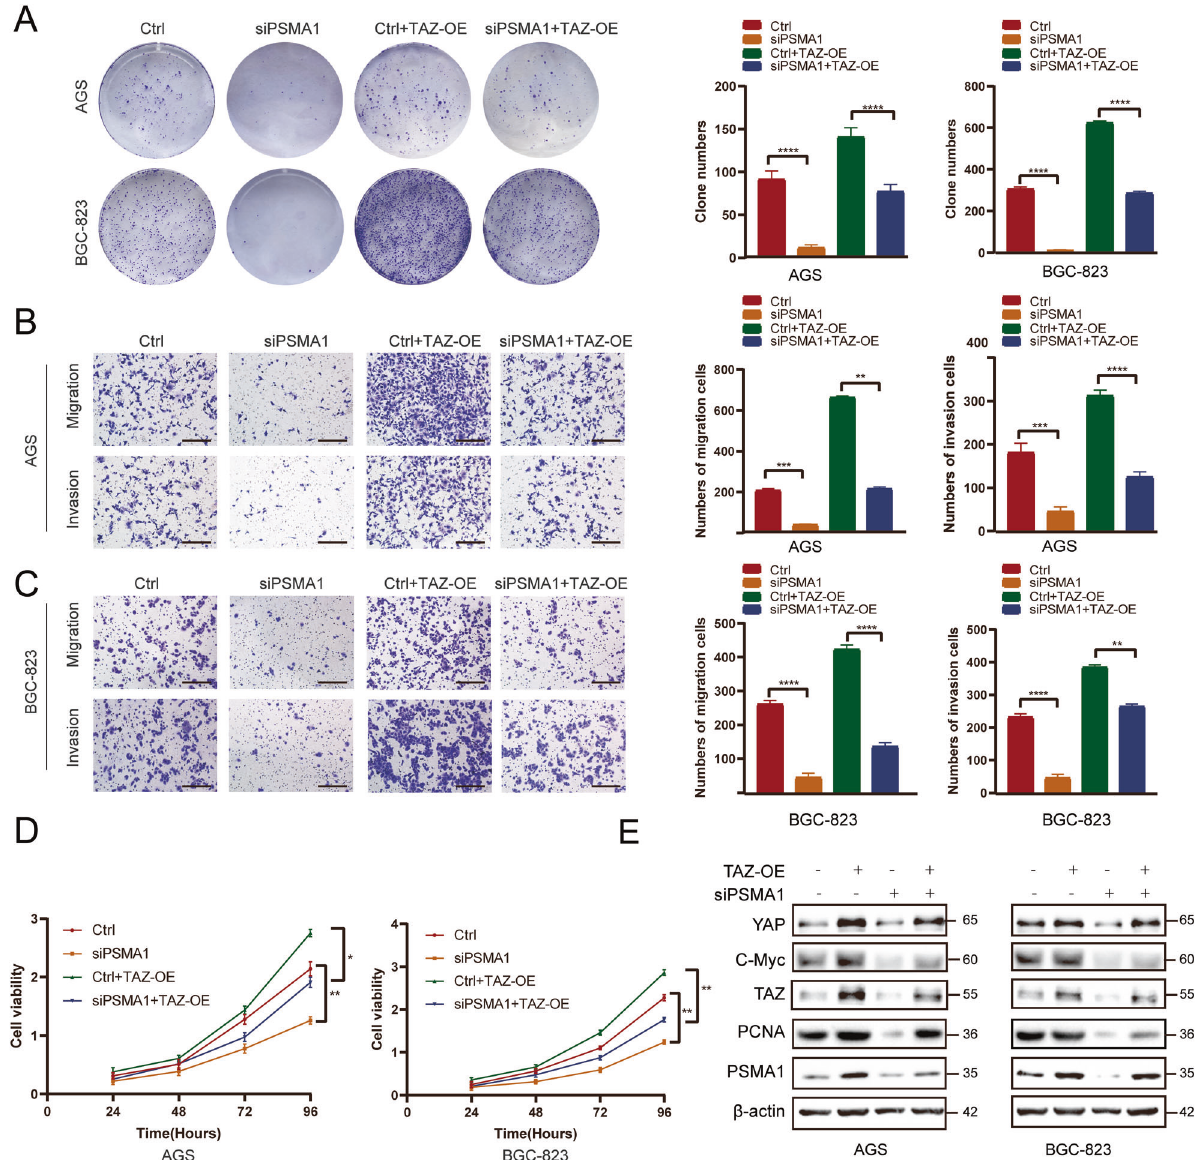
Fig. 6 Oncogenic effect of PSMA1 is dependent on TAZ stabilization. A Colony formation assay was performed to detect the proliferation of GC cells. B Invasion and migration assays were performed to detect the proliferation of AGS cells. Bar length: 100 μ m. C Invasion and migration assays were performed to detect the proliferation of BGC-823 cells. Bar length: 100 μ m. D CCK-8 assay was used to detect the proliferation of GC cells. E Western blot showing TAZ expression and proteins related to cell growth, such as PCNA and C-Myc in GC cells after a knockdown of PSMA1 and overexpression TAZ or only knockdown